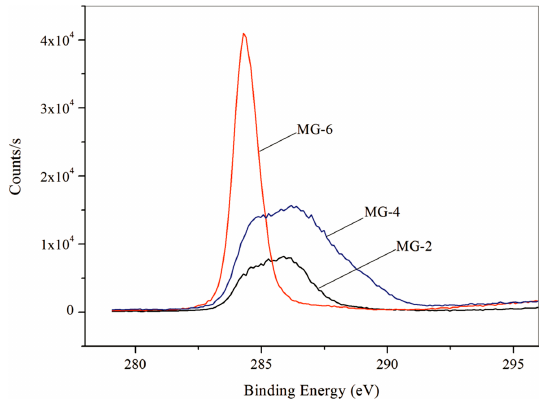
Figure 8. X-ray photoelectron spectroscopy (XPS) curves of microPCMs samples (MG-2, MG-4, and MG-6).